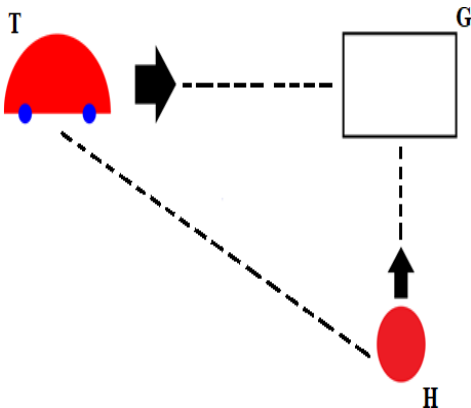
Figure 3. Graphical representation of the experimental task presented on a large touchscreen, where participants had to move up the red dot with the fingertip of their right dominant hand (H) and intercept the horizontally moving target car (T) at the rectangular goal location (G). The car was moving from left to right on the screen towards the interception area under three randomly presented constant accelerations: 0.12 m/s² (slow), 0.33 m/s² (medium), and 0.58 m/s² (fast). The target car (T) was moving towards goal location (G) while the hand (H) was also moving towards G to intercept the moving car.